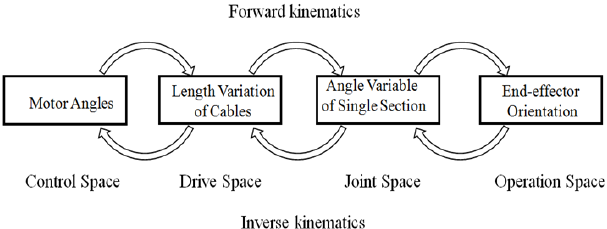
Figure 4. Multilevel mapping relationships of the CDSLM.